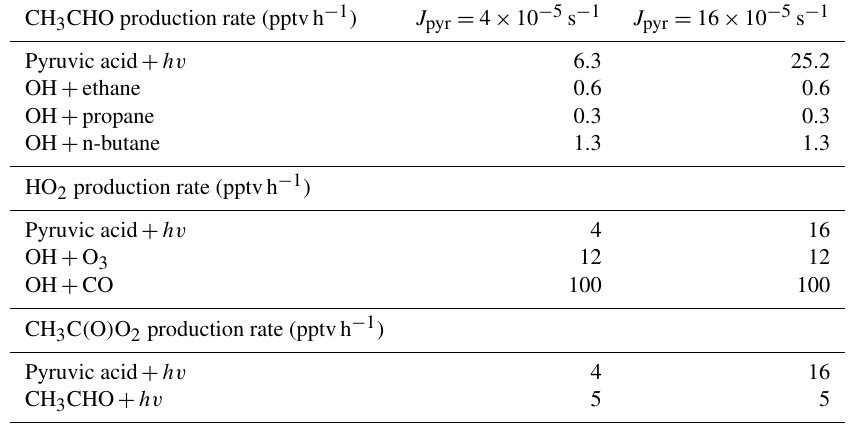
Table 2. Calculated production rates of acetaldehyde, HO 2 and CH 3 C ( O ) O 2 from the photolysis of pyruvic acid at solar noon. CH 3 CHO production rate (pptvh − 1 )